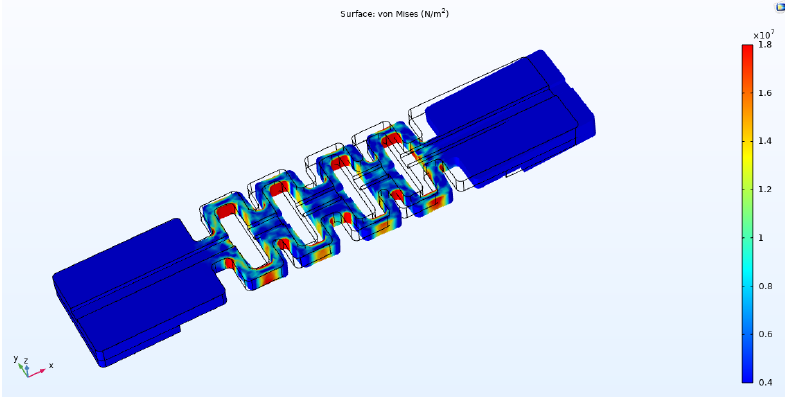
Figure 3. Stress contour plots of PLA-AE-FBG1.